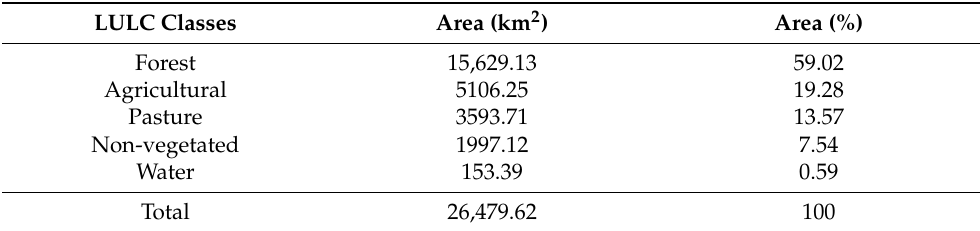
Figure 8. LULC map based on OBC (Reference Frame: WGS84/UTM35S). Table 6. Extent of LULC classes in GD.